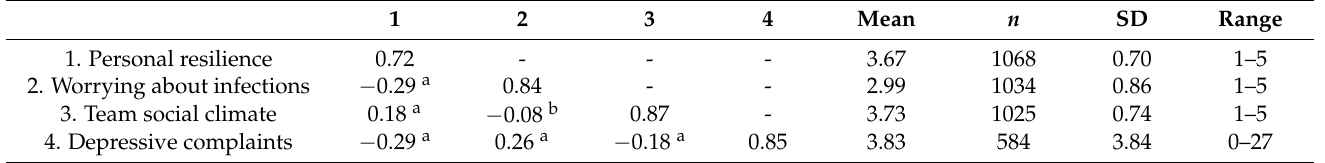
Table 1. Correlations, Cronbach’s alphas, means, standard deviations, and ranges for the main study variables.